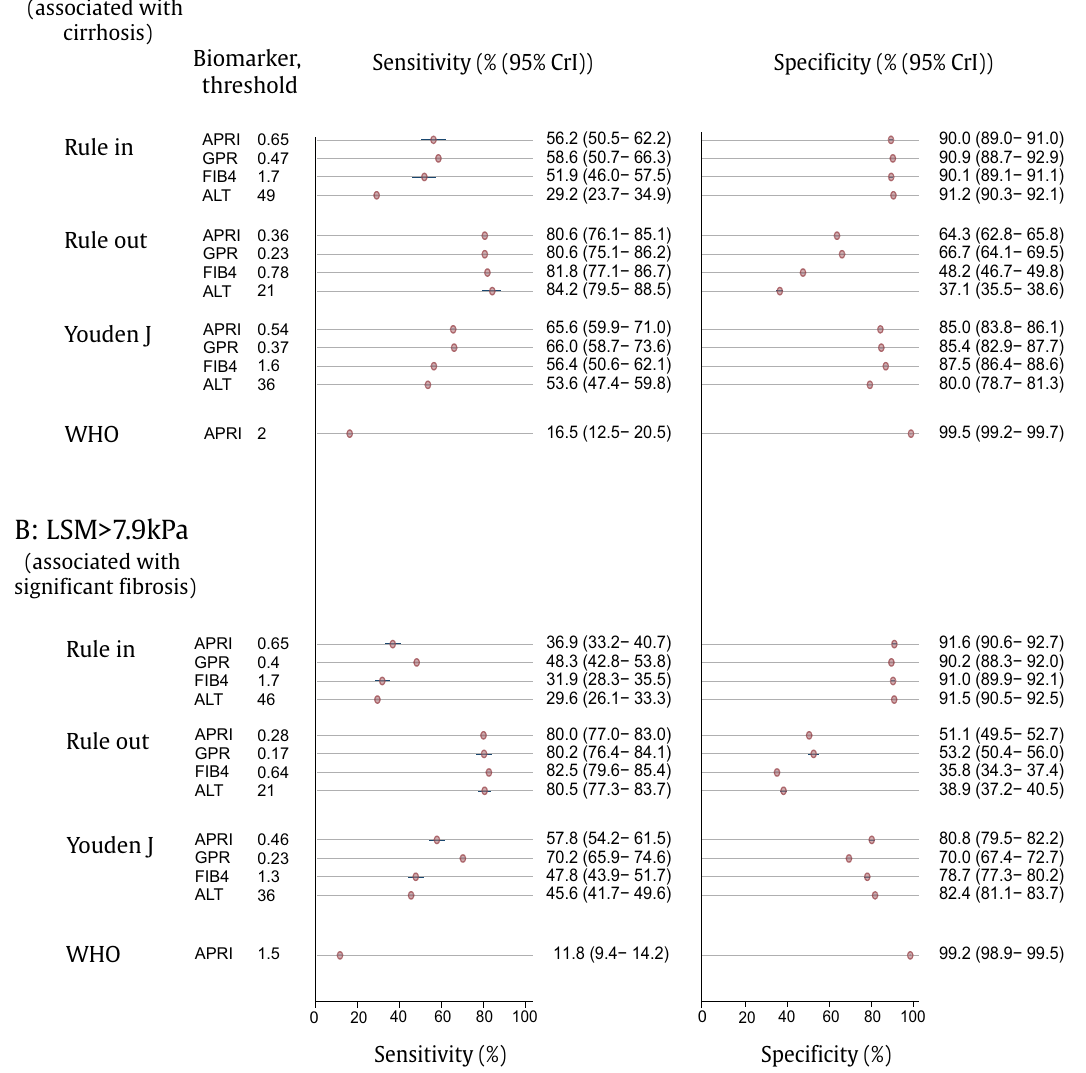
liver stiffness measurement. a Bayesian bivariate random effects model ( n =3548 biologically independent samples) adjusted for sex, study, hazardous alcohol consumption, reason for testing (suspected liver disease or asymptomatic screening) and categorical body mass index; summary statistics show population average. Youden ’ s J=maximisation of Youden ’ s J statistic, with equal weight to sensitivity and speci fi city (J=sensitivity + speci fi city − 1). Rule-in models were chosen where speci fi city exceeds 90%; rule-out models where sensitivity